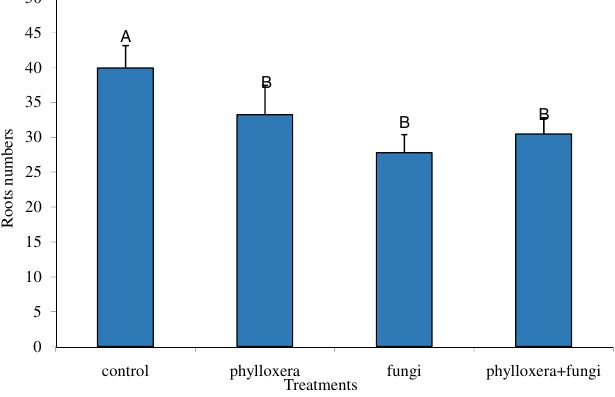
Fig . 2. Effects presents of phylloxera and fungi on roots numbers Fig. 2 - Effects presents of phylloxera and fungi on roots